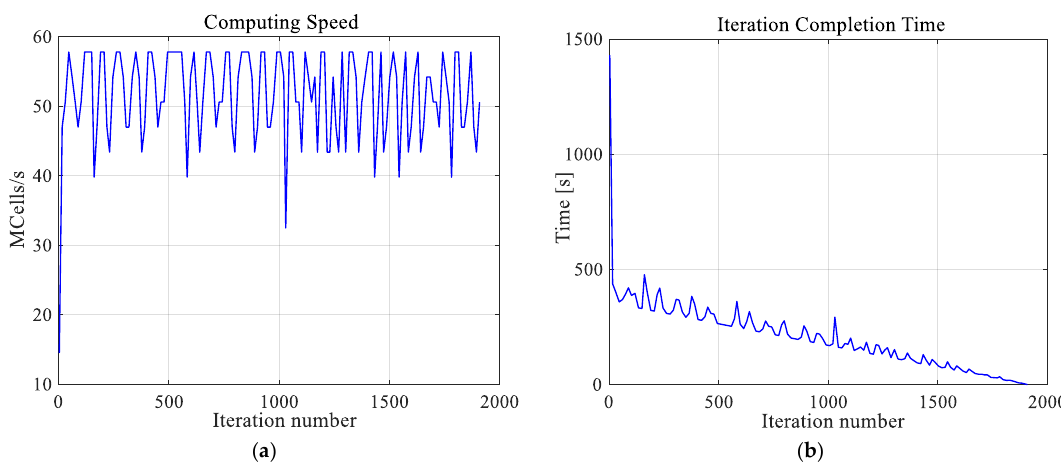
Table 2. The optimized parameters of an eight-dipole antenna array for various breast tumor sizes. Tumor Size r = 2 mm Antenna